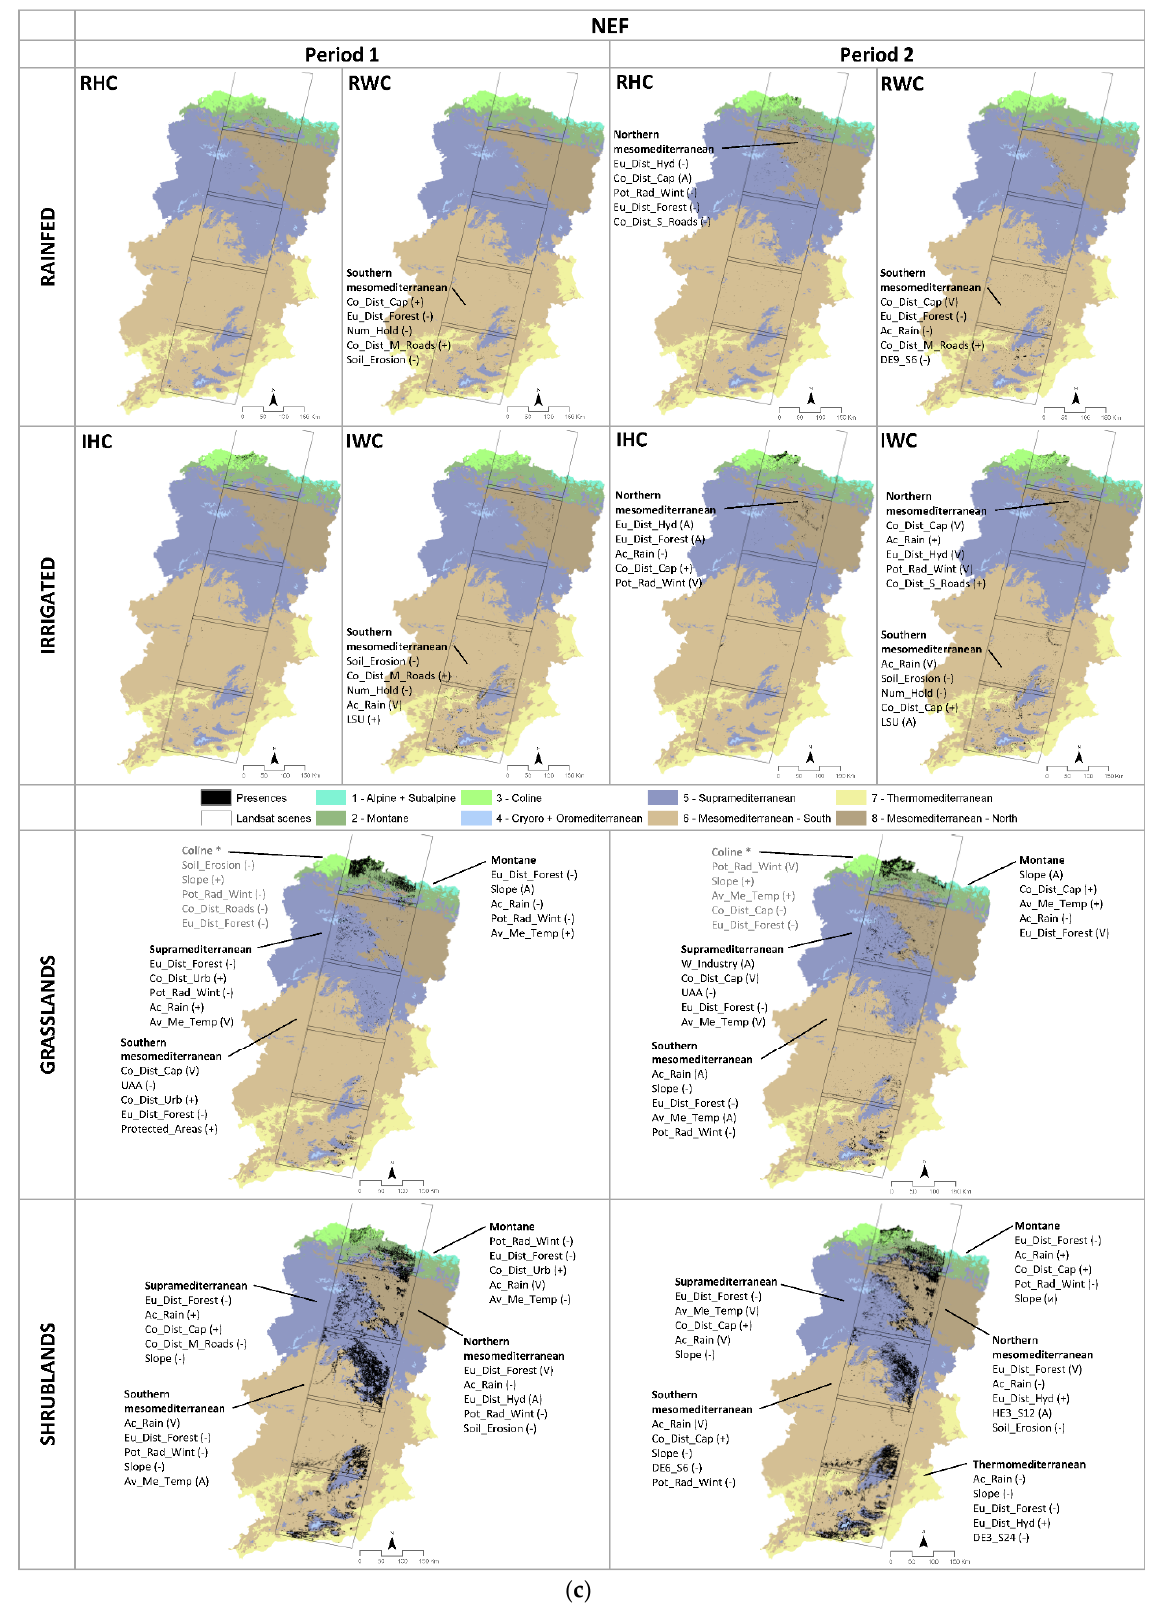
Figure 5. ( a ) Main drivers derived for each target forest, source category and period. Drivers are listed in order of importance. ( b ) Figure continuation. ( c ) Figure continuation.